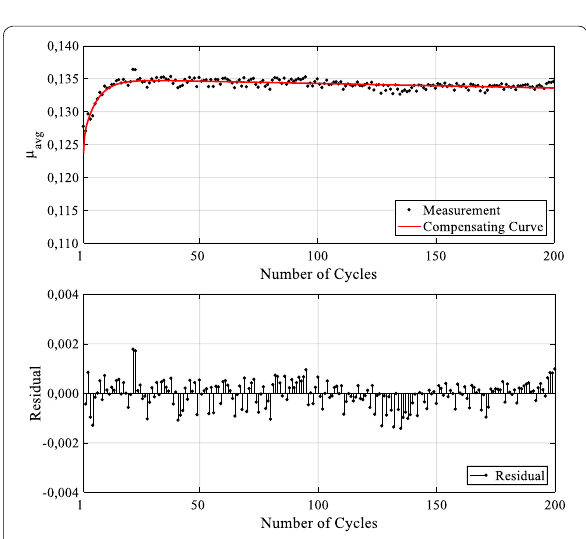
Figure 13 Sample friction trend plot µ avg with compensating curve and residuals for tribological system